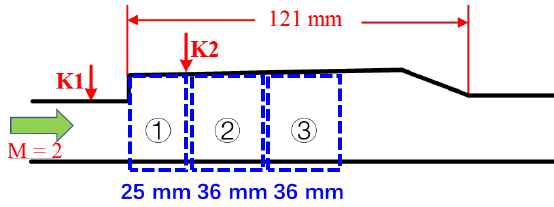
Figure 9. Schematic of the three regions.